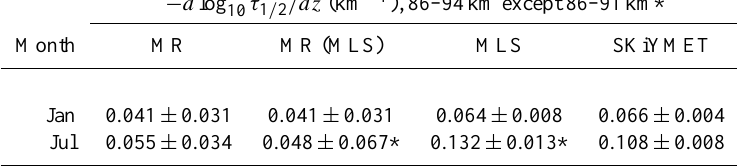
Table 1. Comparison log 10 τ 1 / 2 slope estimates. MR are from fits to average and SD over all selected meteors at each height and month, 86–94km. MR(MLS) is the same, but only those meteors for which MLS data are available are used (that is, where echo heights do not come from one level beyond 0.001mb); MLS are fits to τ 1 / 2 values from average daily T , P (second-order polynomial fit to height profile) and inversion of Eq. (6) for each meteor height. The SKiYMET slope was found by inverting Eq. (4) (with a priori knowledge of the daily temperature output and the temperature gradient model that was used). The latter involved very careful detailed meteor echo selection criteria and a specialized fit (Hocking et al., 1997). All results are for composite year: February 2006–June 2012.